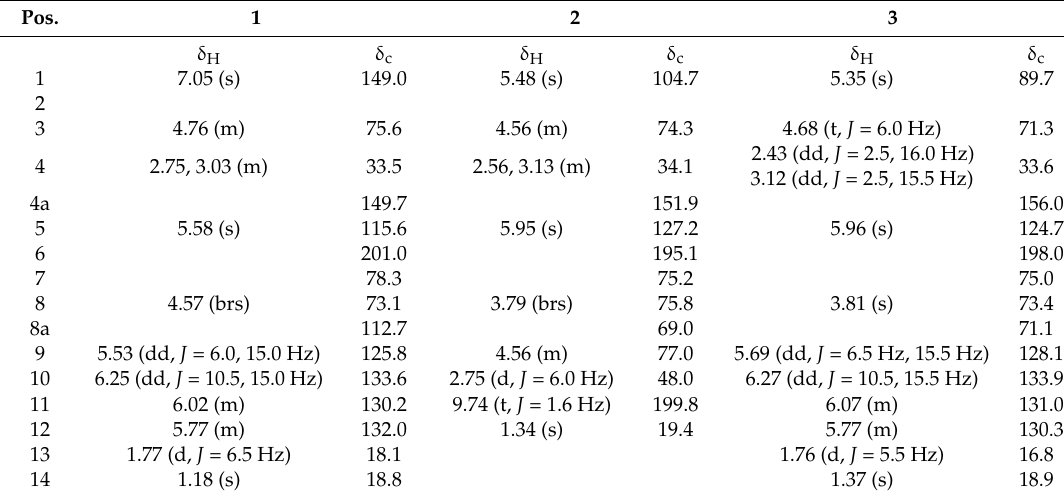
Table 1. 13 C NMR and 1 H NMR data of compounds 1 – 3 .